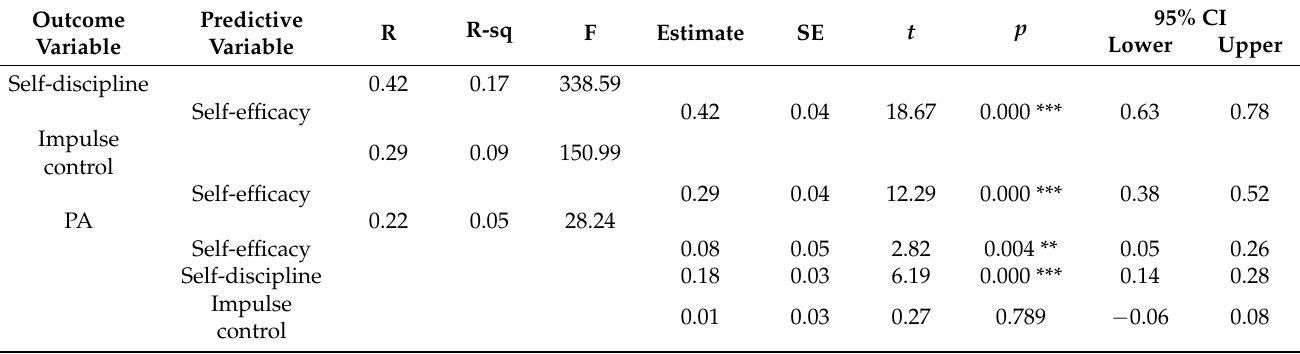
Table 4. Direct and indirect effects of self-efficacy on PA.